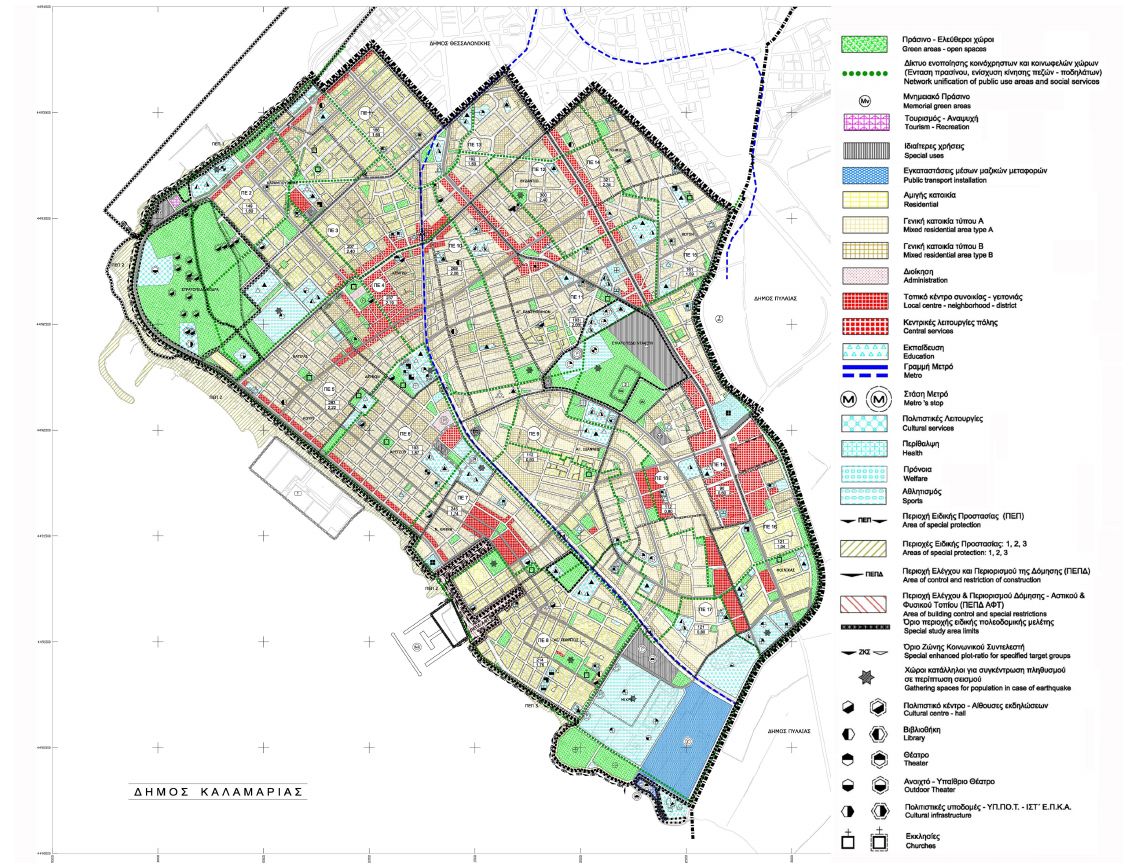
Figure 1. Masterplan of Kalamaria municipality showing the green areas and the green infrastructure network for the unification of public use areas and social services. Adapted from the revised Masterplan of Kalamaria municipality (FEK